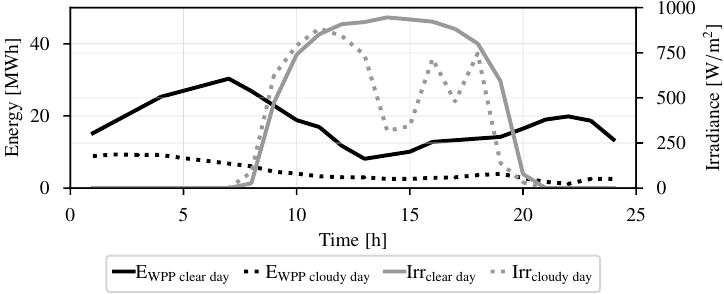
Figure 4. Forecasts for STU, WPP, and PV generation on a clear and cloudy day.